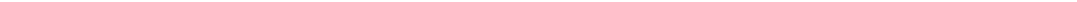
Figure 3: Treatment and re-treatment of relapsing patients and clinically relevant RAS.DCV = daclatasvir; DSV = dasabuvir; ETR = end-of- treatment response; GT = genotype; HIV = human immunodeficiency virus; LDV = ledipasvir; n.a. = test results not available or no RAS test was performed; n/t = not taken (patient did not take RBV); PAR = paritaprevir; OMB = ombitasvir; PEG-INF = pegylated interferon; RAS = re- sistance associated substitutions; RBV = ribavirin; SMV = simeprevir; SOF = sofosbuvir; SVR = sustained virological response; SVR12 = neg- ative HCV-PCR 12 weeks after end of treatment; SVR24 = negative HCV-PCR 12 weeks after end of treatment.* No RAS